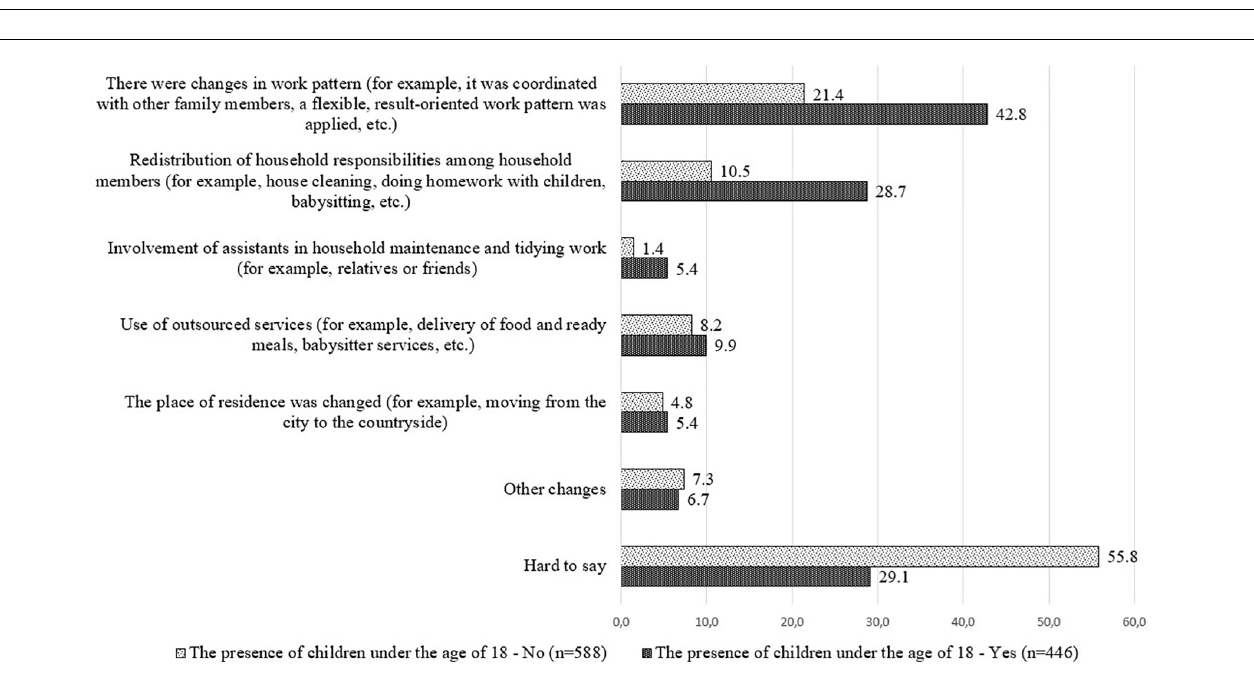
FIGURE 2 | Distribution of answers of employed respondents to the question “Please mark what changes were made to your household’s daily routine during COVID-19 to enhance work–life balance?”; presence of children under the age of 18 in the household; %.